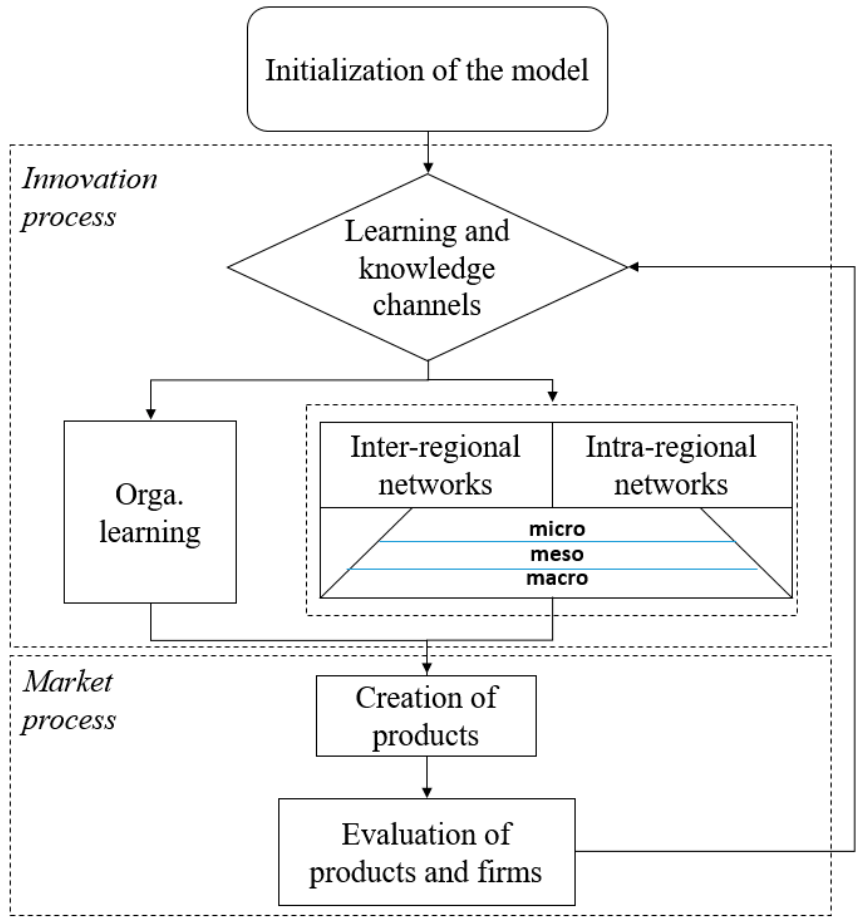
Figure 2. Illustration of the simulation procedures.